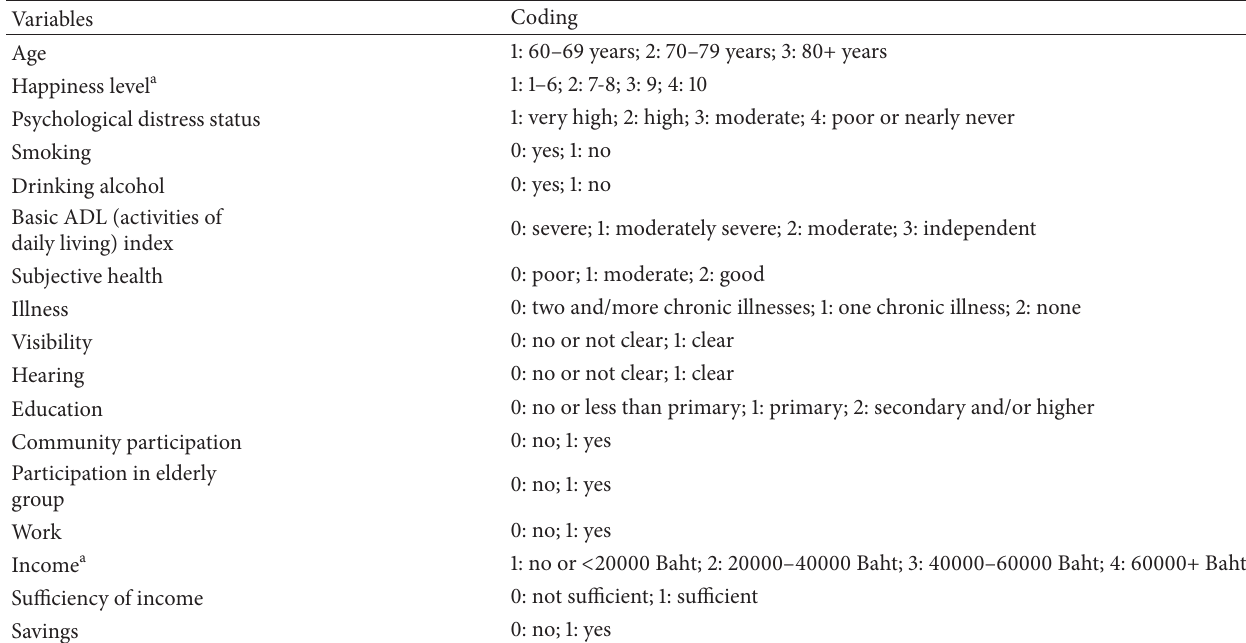
Table 1: Selected indicator variables for validating active ageing determinant factors model in